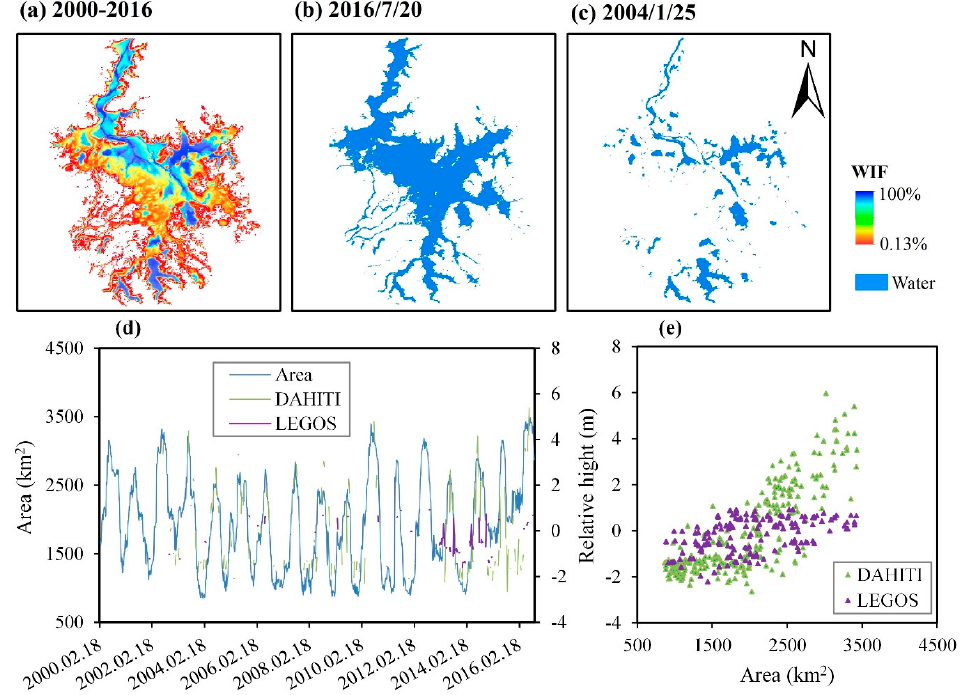
Figure 12. Spatial distribution and temporal variation of Poyang Lake. ( a ) The WIF map in 2000–2016; ( b ) water body map of 2016/7/20, with the largest water area in 2000–2016; ( c ) water body map of 2004/1/25, with the smallest water area in 2000–2016; ( d ) time series of the water area (km 2 ) and relative height (m) in 2000–2016; and ( e ) correlation between water area (km 2 ) and relative height (m).